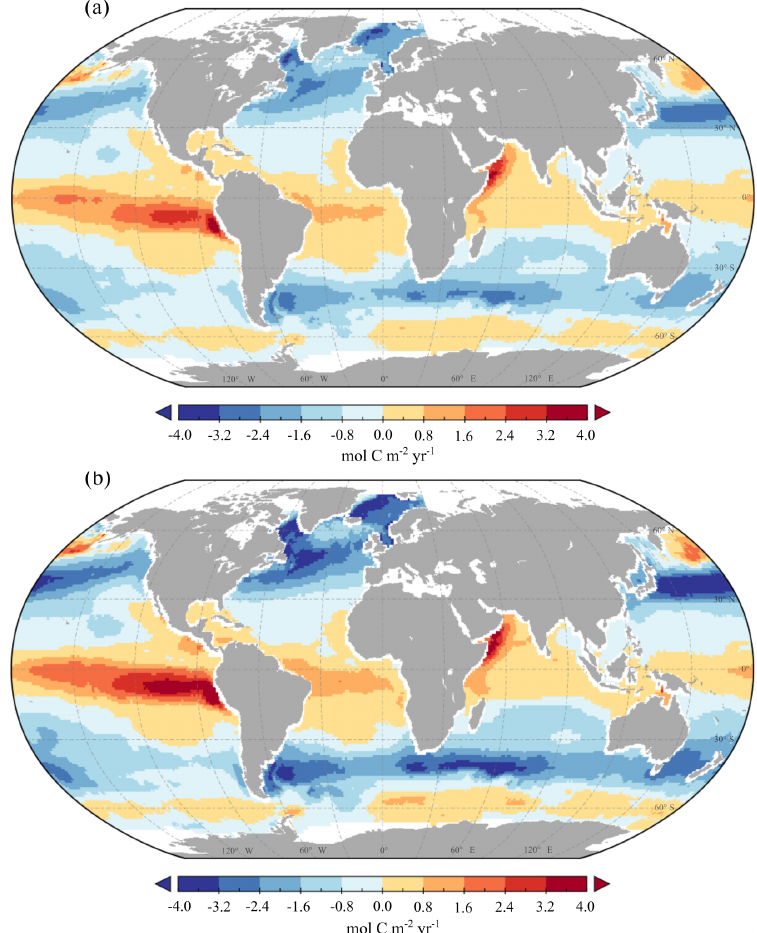
Figure 3. Global distributions of oceanic air–sea mean F CO 2 (molCm − 2 yr − 1 ) generated from a 21 year climatology (1991–2011) using the Wanninkhof (2014) k relationship combined with NCEP1 (a) and NCEP2 (b) wind